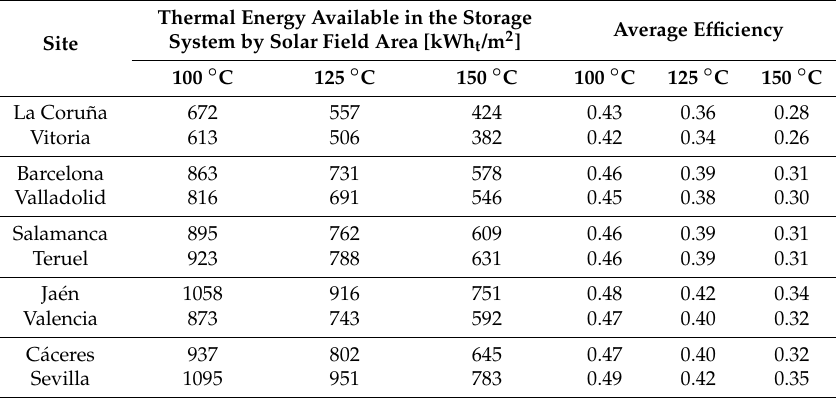
Table 18. Thermal energy available per solar field area and average efficiency for each site and thermal level, CPC technology.